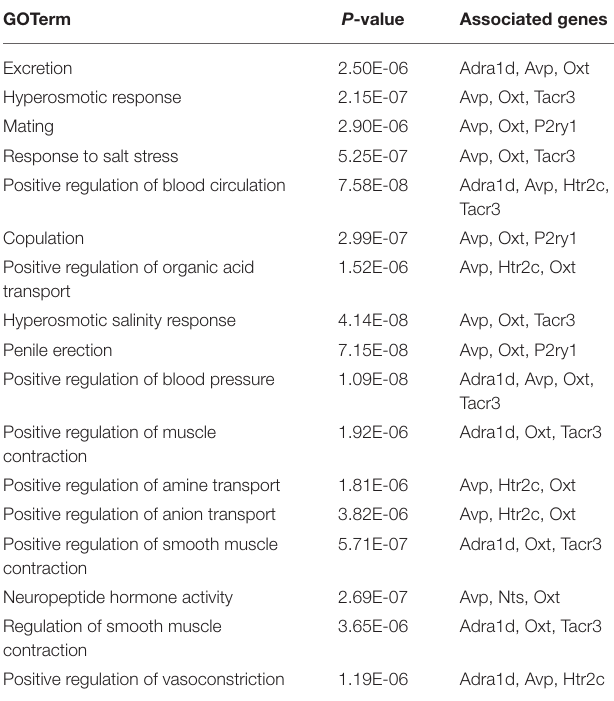
TABLE 2 | GO annotation on the 10 hub genes in E and RE groups. GOTerm P -value Associated